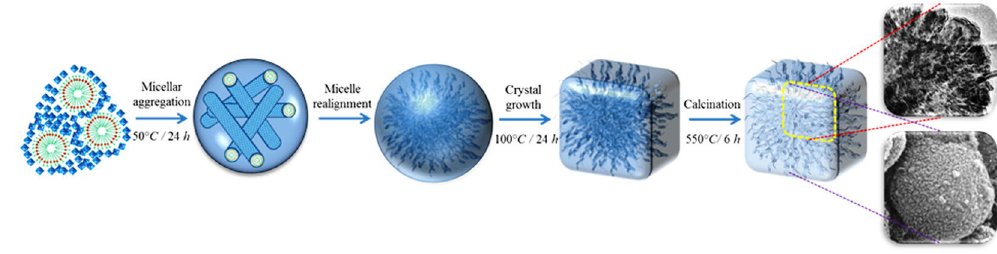
Figure 8. Proposed mechanism for the synthesis of ZH-A with centrosymmetric radial mesopore